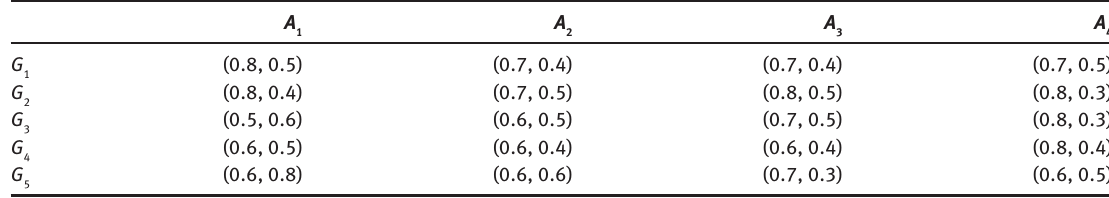
Table 1: Pythagorean Fuzzy Decision Matrix D 1 .